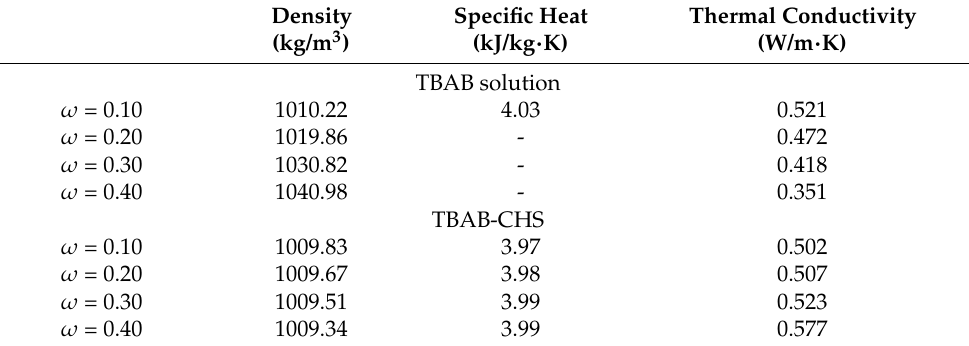
Table 2. Thermo-physical properties of TBAB solution and TBAB-CHS [54].